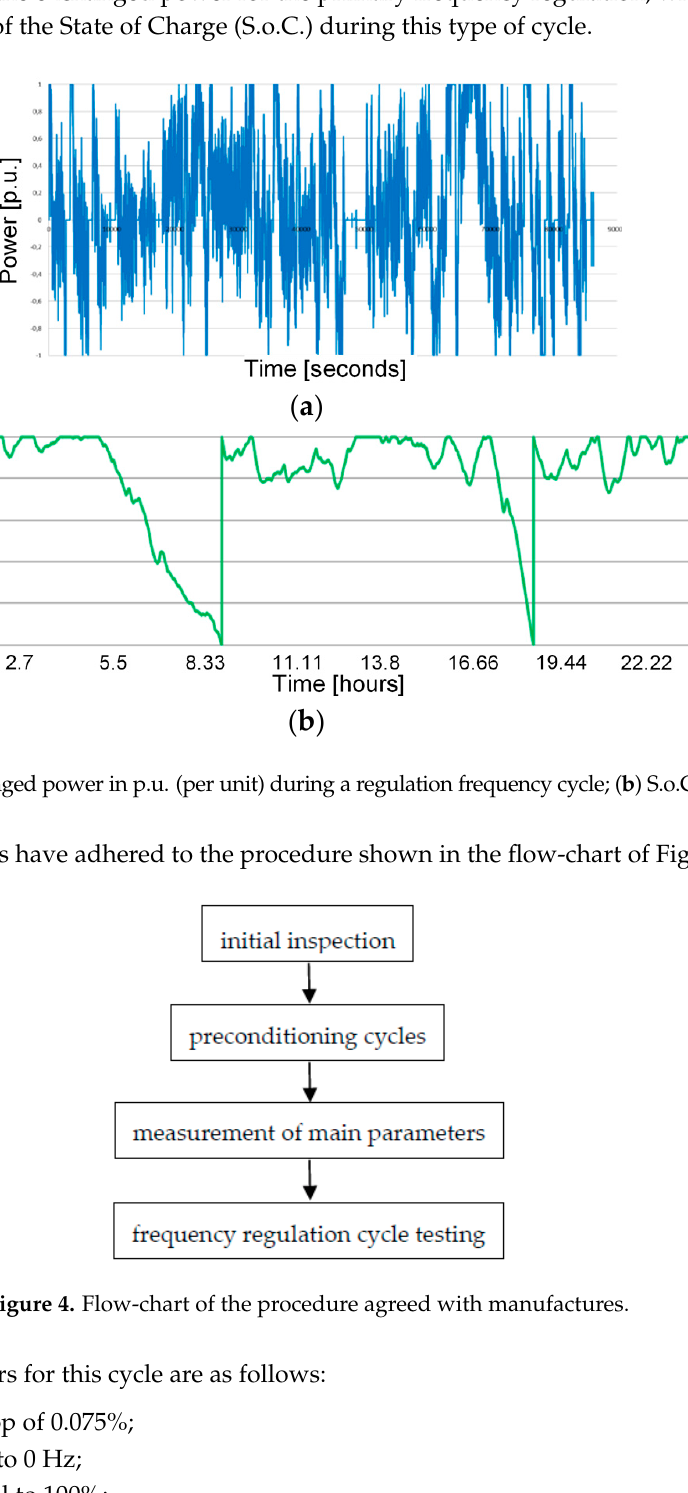
Figure 4. Flow-chart of the procedure agreed with manufactures.